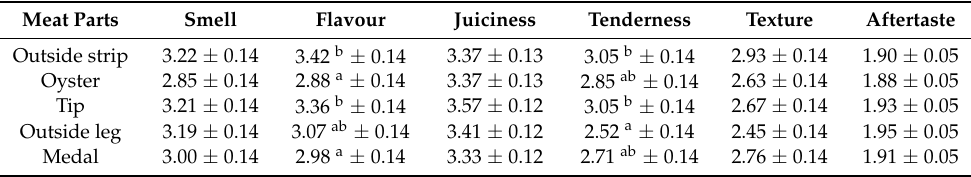
Table 10. Organoleptic characteristics of the examined valuable meat parts ( n =